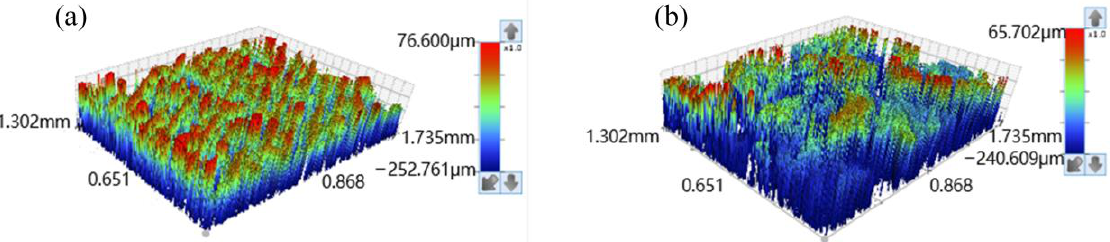
Figure 3. Three − dimensional surface morphology measured by white light interferometer. ( a ) As − SLMed; ( b ) ILPed. The parameters of SLM were 185 W, 0.6 m/s and 0.05 mm and 0.01mm (power, speed, spot diameter and hatch spacing). The parameters of ILP were 180 W, 0.6 m/s and 0.05 mm and 0.01mm (power, speed, spot diameter and hatch spacing). Table 1. Average value of surface roughness.